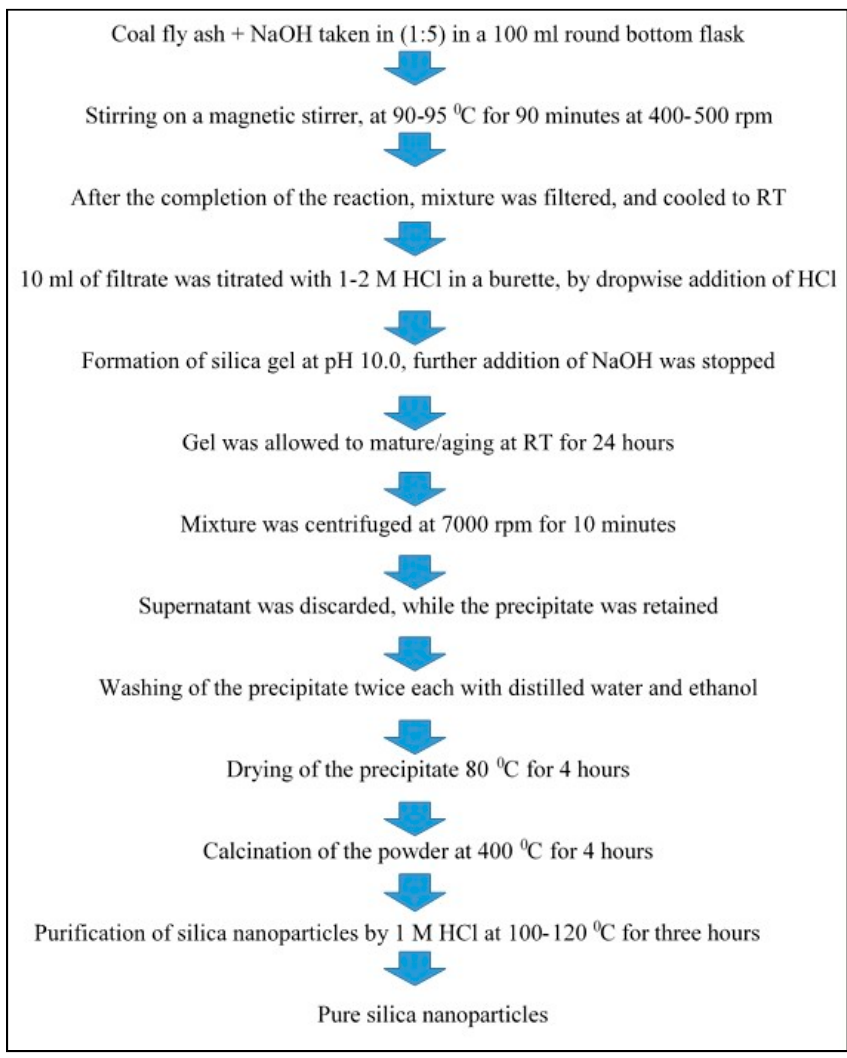
Figure 7. Steps involved in silica synthesis by alkali fusion: chemical method.